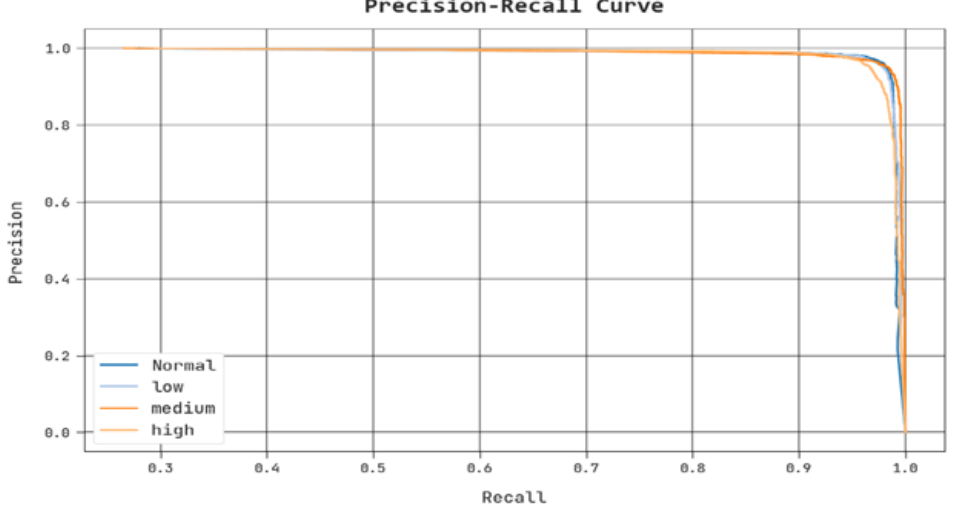
Figure 10. Precision-recall analysis of PPIE-ODLASC methodology. A brief ROC study of the PPIE-ODLASC method under test database is shown in Figure 11. The result denotes the PPIE-ODLASC algorithm has demonstrated its ability in categorizing distinct